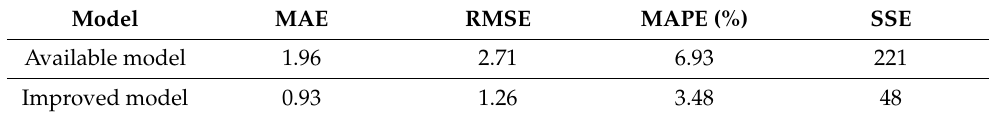
Table 4. Statistical results of each evaluation index of different models.